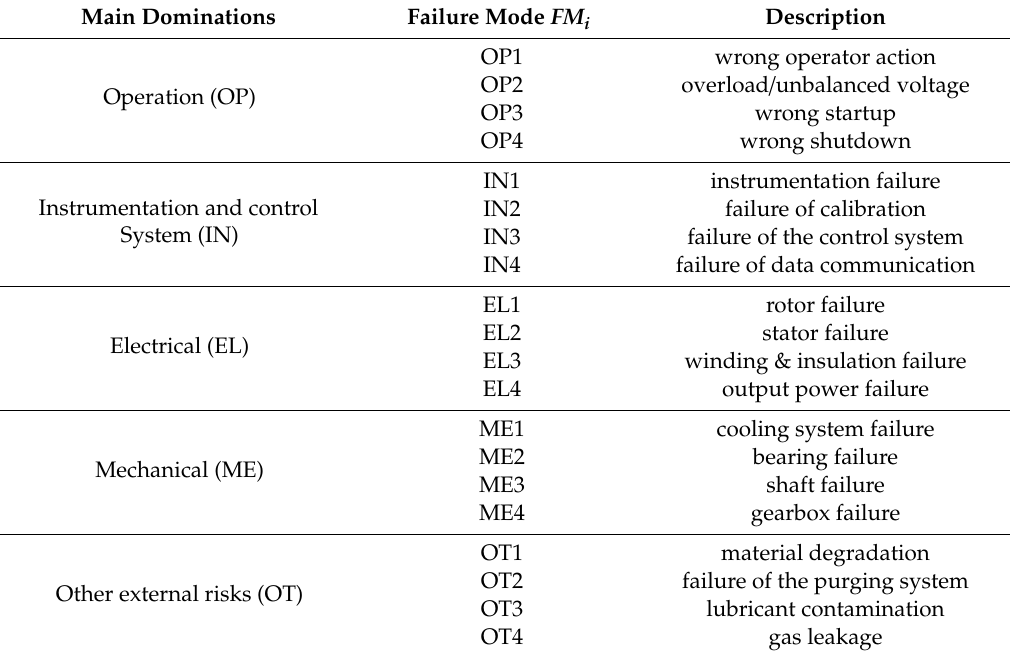
Table 1. Main risk clusters and failure modes [11].